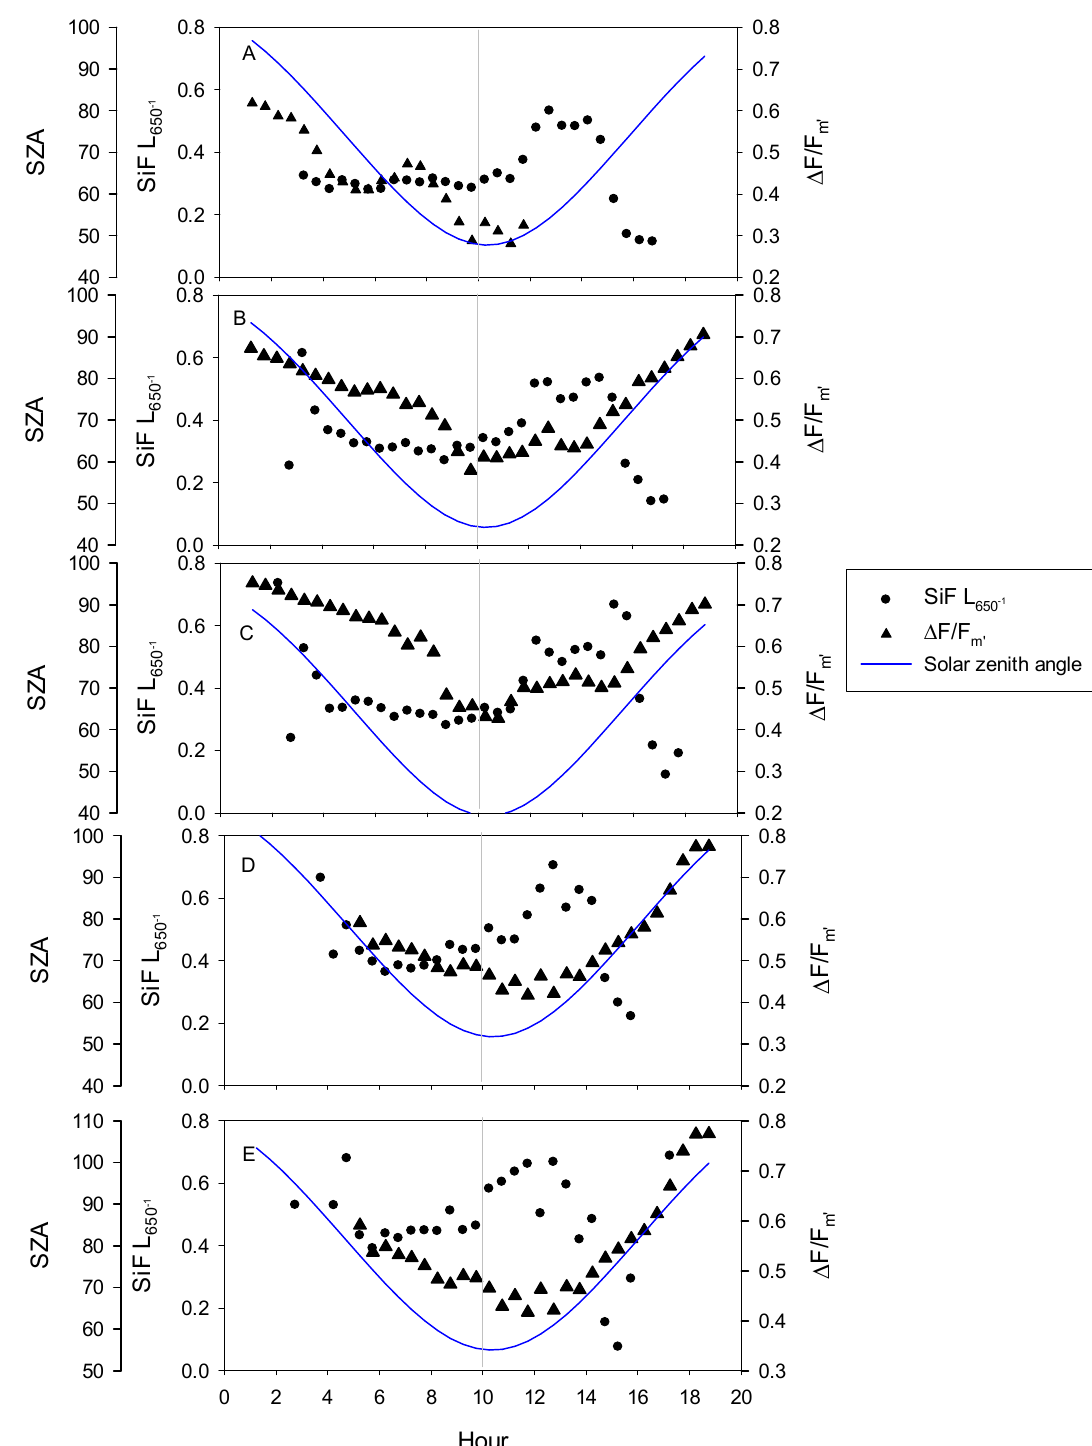
Figure 7. Diurnal course of SiF L 650−1 (black circles), quantum yield of PSII (ΔF/F m ’, black triangles) and solar zenith angle (SZA, blue curve) for the same clear days shown in Figure 6. ( A ) April 28th, ( B ) May 10th, ( C ) June 5th, ( D ) August 27th, and ( E ) September 5th. Note that there are no PAM data for July. Solar noon indicated by the grey line.